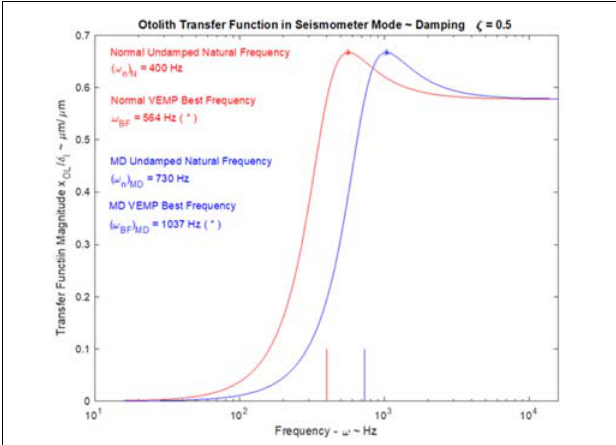
FIGURE 12 | Utricle frequency response (Bode Plot) in Seismometer Mode (shown in red) using estimated UDNF of 400 Hz (shown as vertical red line) and damping ratio of ζ = 0.5 (Dunlap and Grant, 2014). The best test frequency is 564 Hz, shown as red asterisk (*). The frequency response curve for Menière’s Disease (shown in blue) using and estimated UDNF of 730 Hz and with a best frequency of 1037 Hz shown as blue asterisk